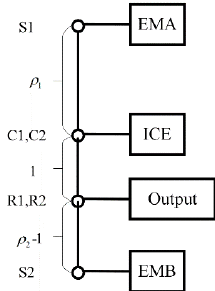
Figure 6. A new four-shaft hybrid transmission.